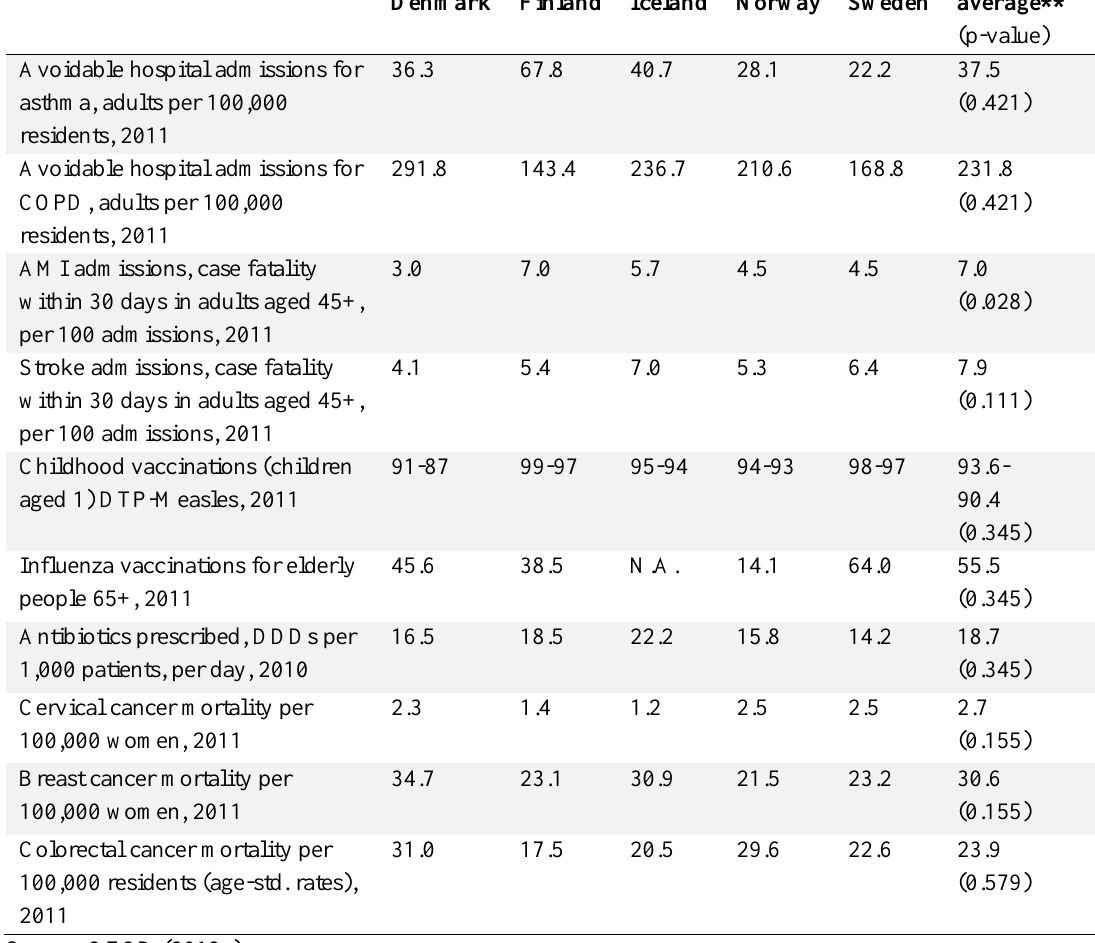
FCC average** (p-value)